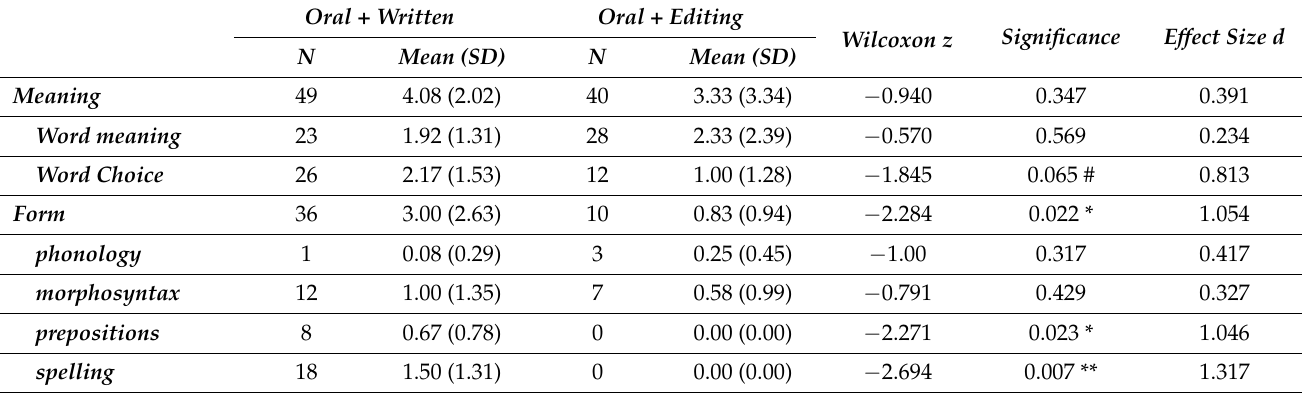
Table 1. Task-modality comparisons for the production of